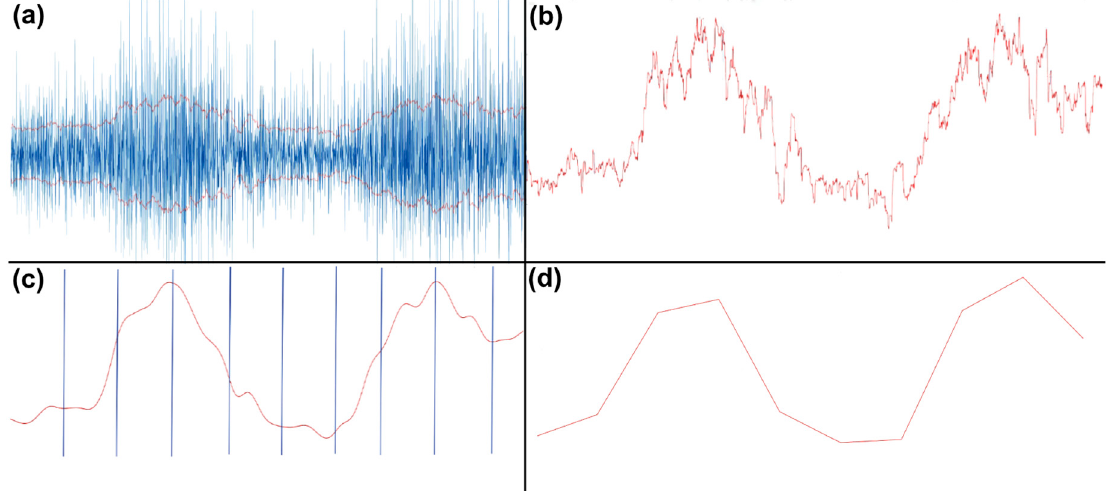
Figure 4. EMG processing steps. ( a ) RMS of high-passed EMG data. ( b ) Positive portion of the envelope. ( c ) Gaussian smoothed and broken into equal 100-point time bins. ( d ) Averaged time bins, resulting in 10 values, plotted here as a